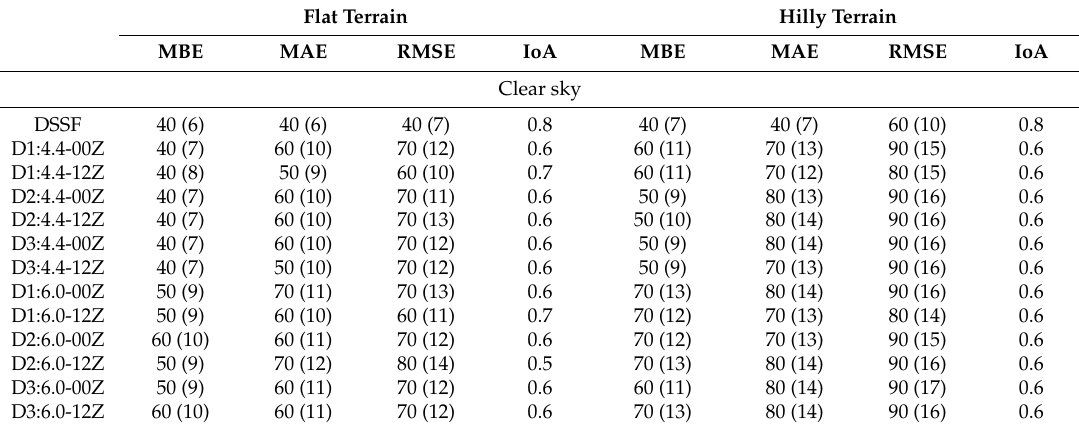
Table 2. Daily solar radiation error and accuracy statistics, depending on flat or hilly terrain and clear or cloudy conditions, during the summer 2011. MBE, MAE and RMSE in W ¨ m ´ 2 . Relative errors (%) rMBE, rMAE and rRMSE in brackets at the